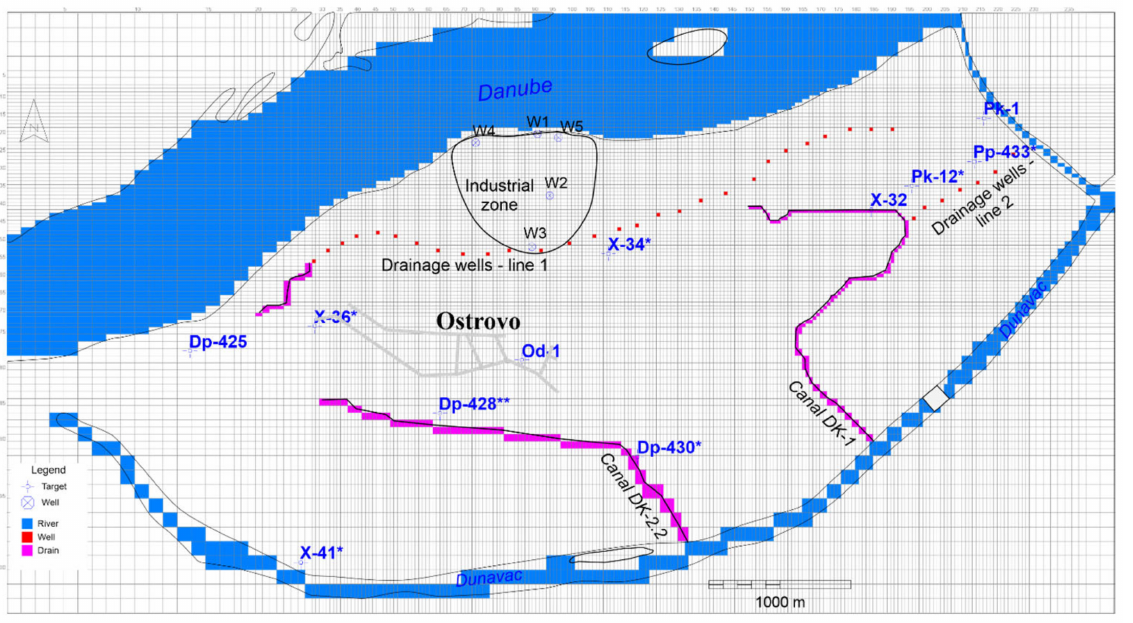
Figure 4. Discretization of the modeled study area and boundary conditions of the second model